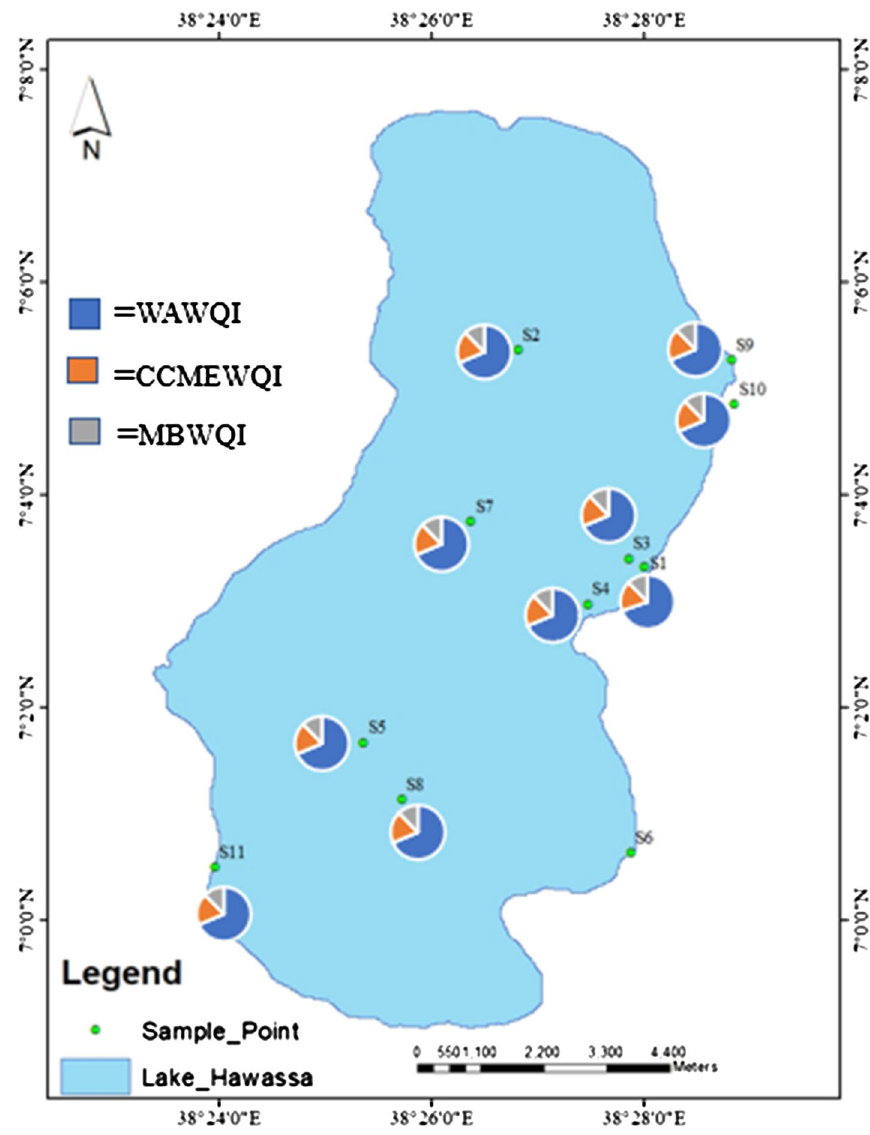
Fig. 3 Sampling points with water quality